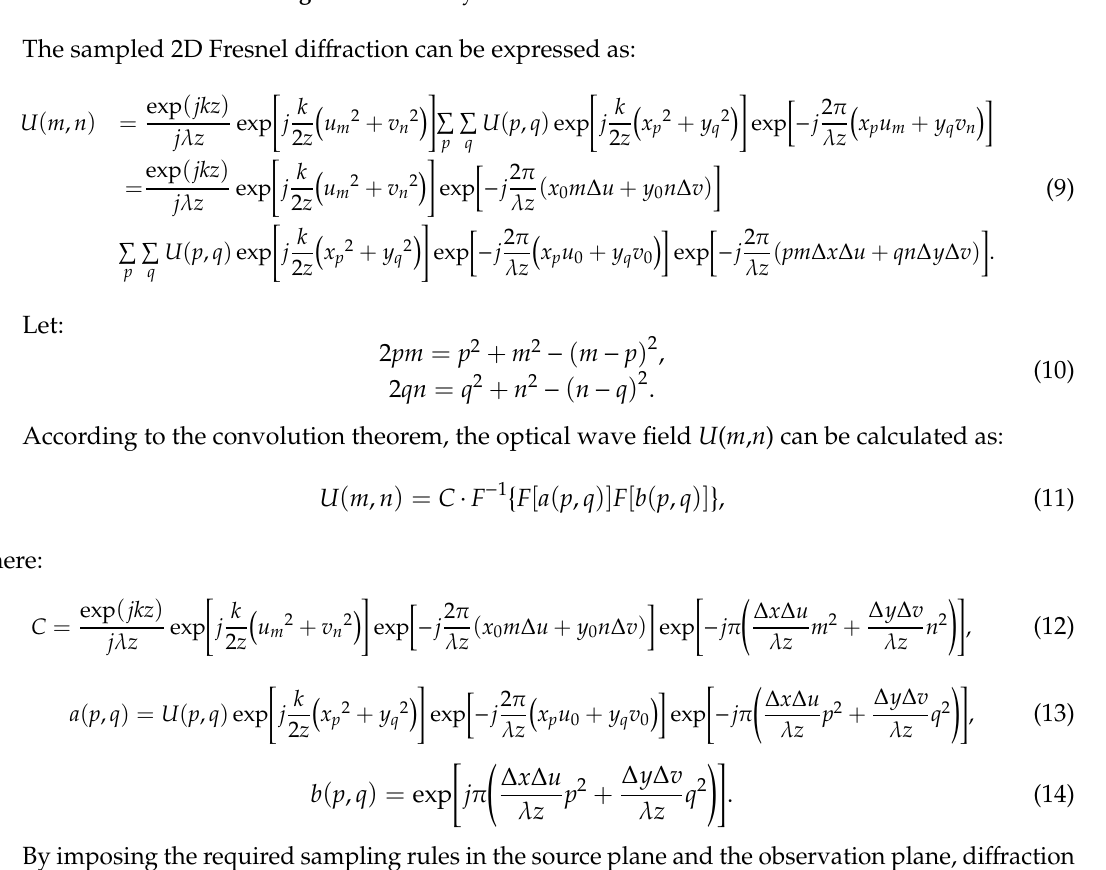
Figure 1. Geometry of shifted Fresnel diffraction.